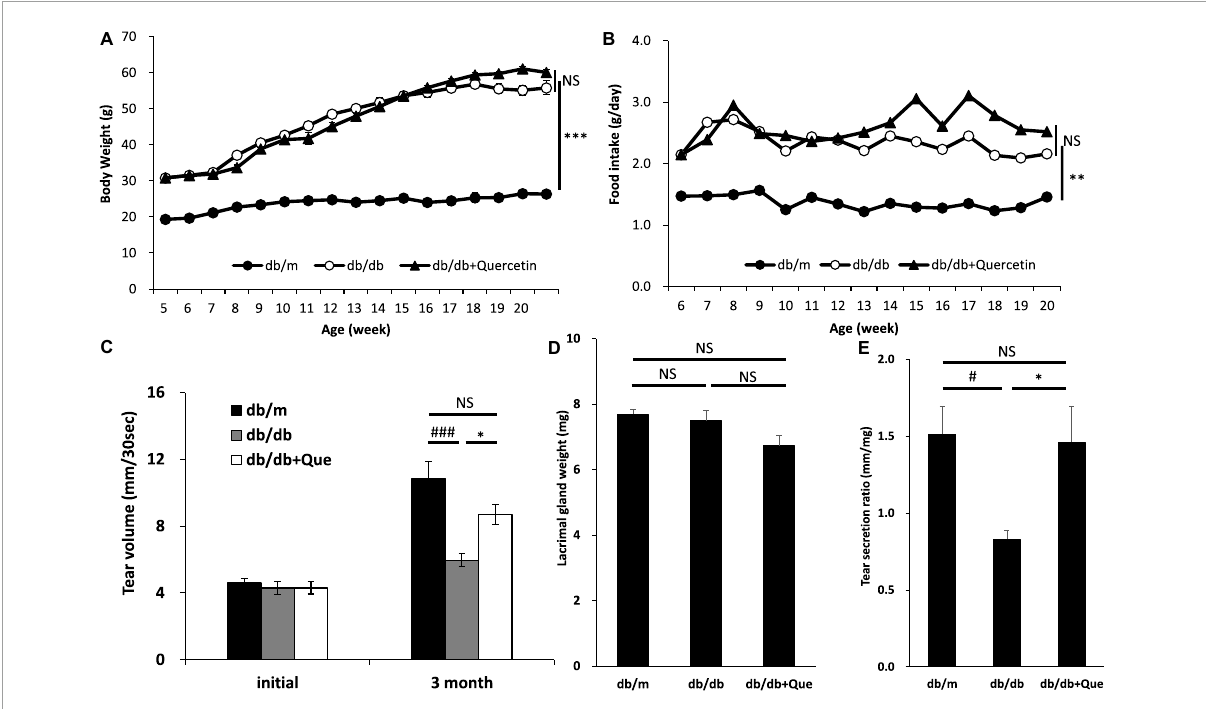
FIGURE1 Effect of quercetin on decreased tear production in the db/db diabetic mouse model. (A) Time course of body weight. The mean values for body weight of db/m ( n = 10), db/db ( n = 10) and db/db + quercetin ( n = 10) mice from 6 to 26 weeks of postnatal age. (B) Time course of food intake (g/day). Mice in the same groups as (A) were placed on either a CE-2 or CE-2 with 0.5% of quercetin for 26 weeks. (C) Basal tear volume of the db/m, the db/db, and the db/db + quercetin animals at the initiation (6 weeks of age) and 12 weeks after the start of the experiment. (D) Mean values for lacrimal gland weight of the db/m, the db/db, and db/db + quercetin mice. (E) Relative tear secretion refers to tear secretion volume adjusted for weight of each lacrimal gland in the corresponding animal. All data are presented as means ± standard error of the mean (SEM). Statistical significance was calculated by Bonferroni’s correction, ∗∗∗ P < 0.001; ∗∗ P < 0.01; and ∗ P < 0.05 vs. db/db group, ### P < 0.001; # P < 0.05 vs. db/m group. NS: not